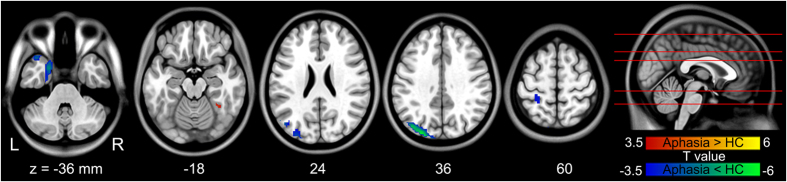
Abnormalities in the seed-based (right hippocampus/parahippocampus) functional connectivity data from aphasic patients.Brain regions showing FC differences between patients with aphasia and controls by two-sample t-test (p < 0.05 FDR-corrected and minimum cluster size of 30 voxels). Warm and cold colors indicate regions with increased and decreased FC values in aphasia, respectively. Numbers below the axial slices refer to the z-plane coordinates of the MNI space, respectively. Letters L and R correspond to the left and right sides of the brain, respectively. Further details of these regions are presented in Table 4.